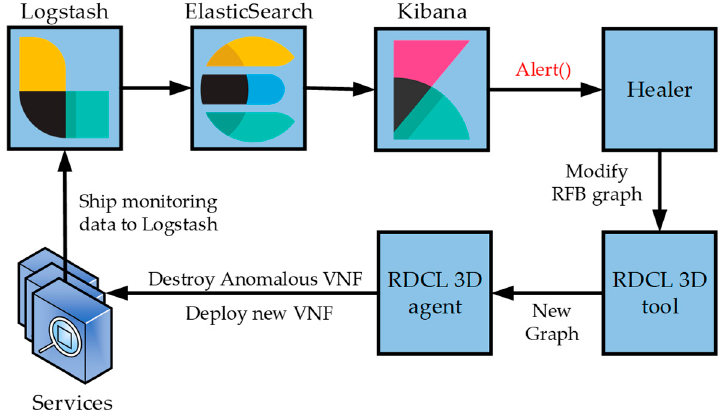
Figure 9. Operation of the Monitoring Value Added Service.